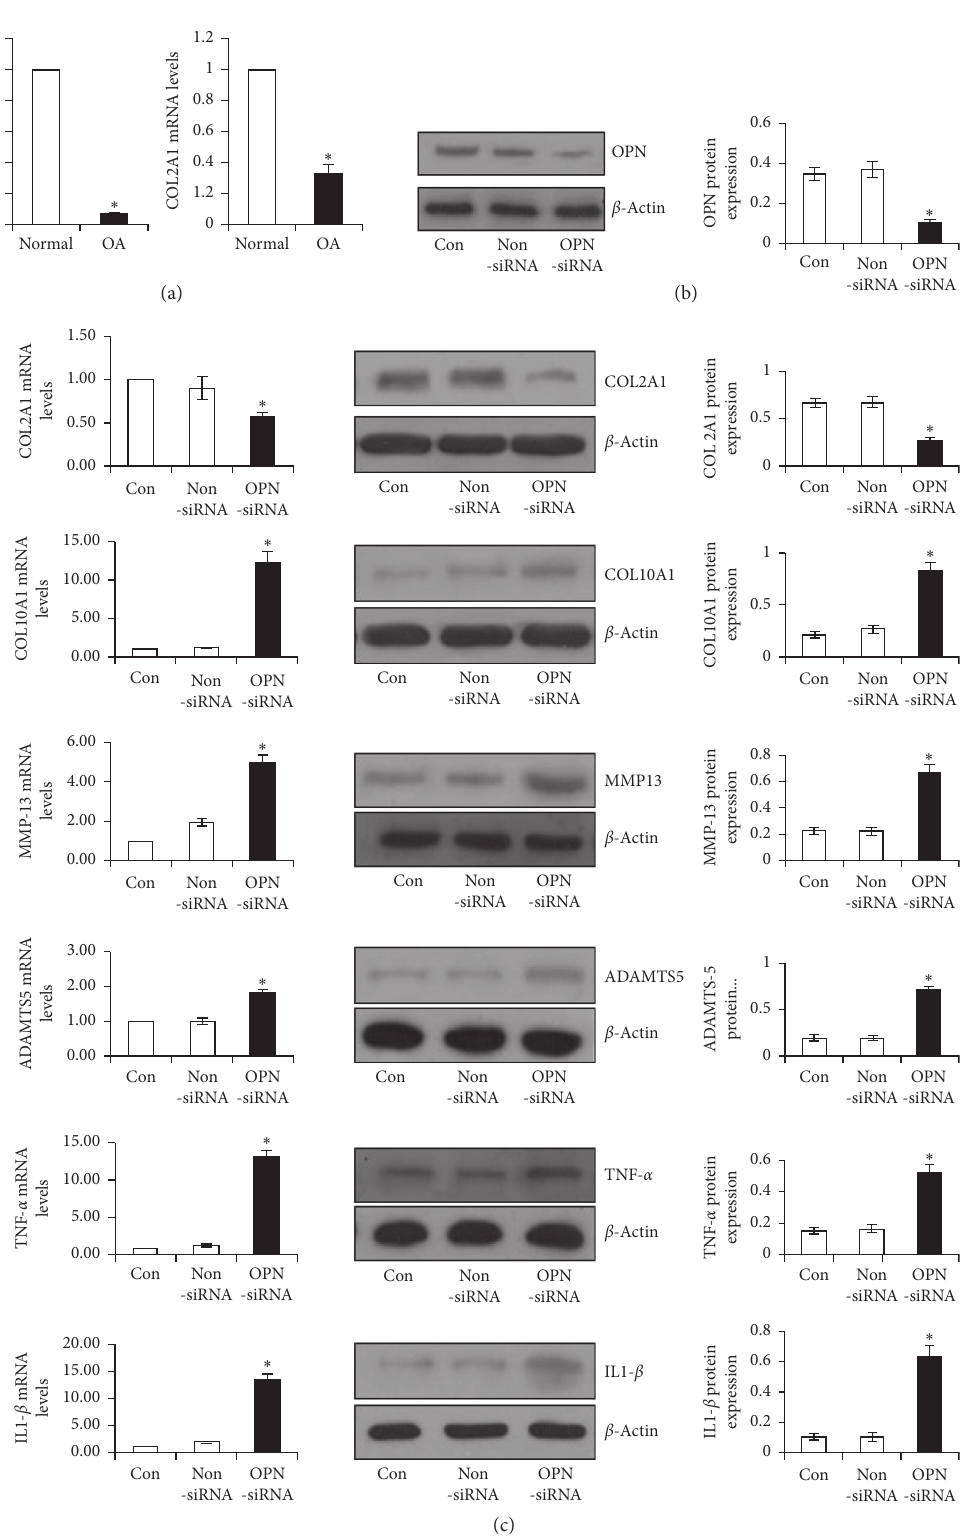
Figure 1: Expressions of OPN and COL2A1 of the human OA chondrocytes and effects of OPN siRNA on the expression of osteoarthritis- associated genes. (a) The mRNA levels of OPN and COL2A1 in OA chondrocytes and in normal chondrocytes ( ∗ p < 0 . 05 vs normal). (b) Western blot analysis was developed to evaluate the knockdown efficiency of OPN siRNA transfection. (c) Effects of OPN siRNA on the gene levels and protein levels of COL2A1, COL10A1, IL-1 β , TNF- ɑ , MMP-13, and ADAMTS5 ( ∗ p < 0 . 05 vs control or